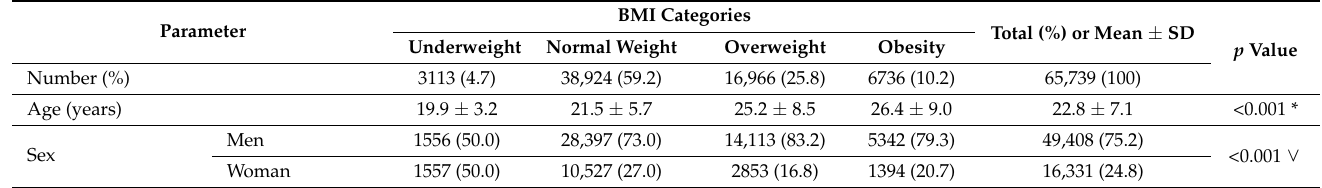
Table 1. Socio-demographics of the study population across the four Body Mass Index (BMI) cate- gories * ANOVA, ˅ Likelihood ratio, SES: Socio-economic status, FSU: Former Soviet Union.